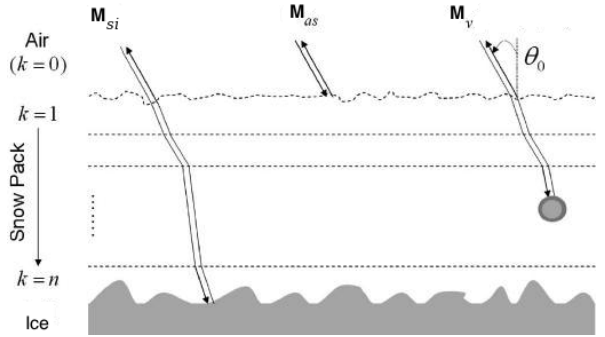
Figure 2. Main backscattering mechanisms occurring within a multilayer snowpack obtained from the radiative transfer equation at first order (Longepe et al., 2009): air–snow reflection ( M as ), volume scattering ( M v ) and reflection over the snow–ice interface ( M si ).